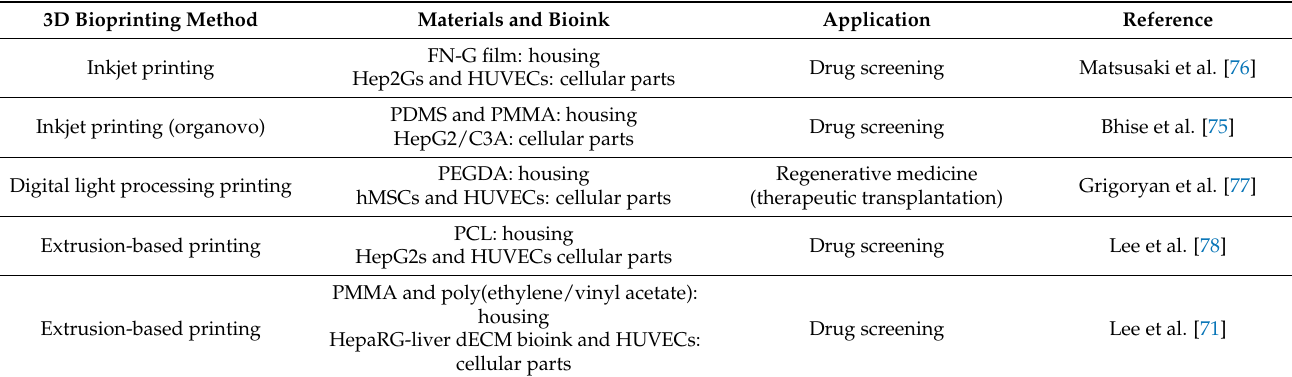
Table 2. Three-dimensional-bioprinted liver-on-chip